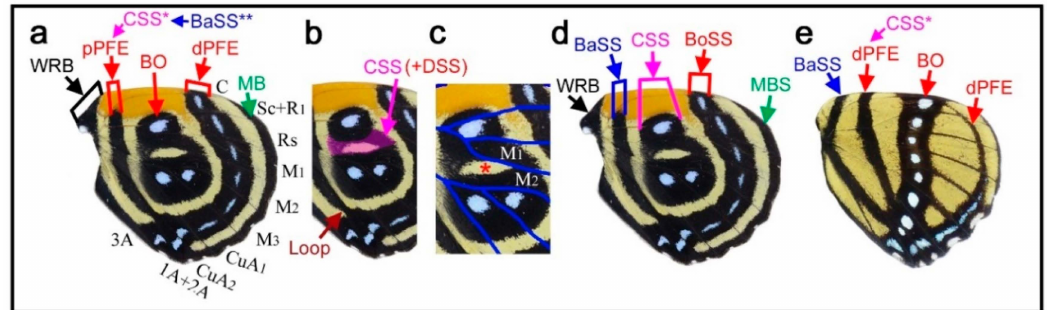
Figure 6. Analysis of eyespot-like structures at the center of the wing in Callicore cynosura and Callicore cajetani . See Figure 1b for abbreviations. ( a ) Callicore cynosura with the preferred element identification. Alternative identifications of pPFE are indicated as CSS* and BaSS** (not preferred). The names of wing compartments are indicated. ( b ) The central area of the wing shown in a. The possible central symmetry system (CSS) around the potential DS area is highlighted in pink. Looping connections between the distal and proximal parafocal elements are indicated. ( c ) Further magnification of the central area of the wing shown in a. Wing veins are indicated in blue. An asterisk at the center of the wing indicates the location of the potential discal spot. The compartments M 1 and M 2 (assuming the presence of the discalis cross vein) are indicated. ( d ) Callicore cynosura with alternative identifications (not preferred). This wing image is identical to a except for the identifications of elements. ( e ) Callicore cajetani . An alternative identification of pPFE is indicated as CSS* (not